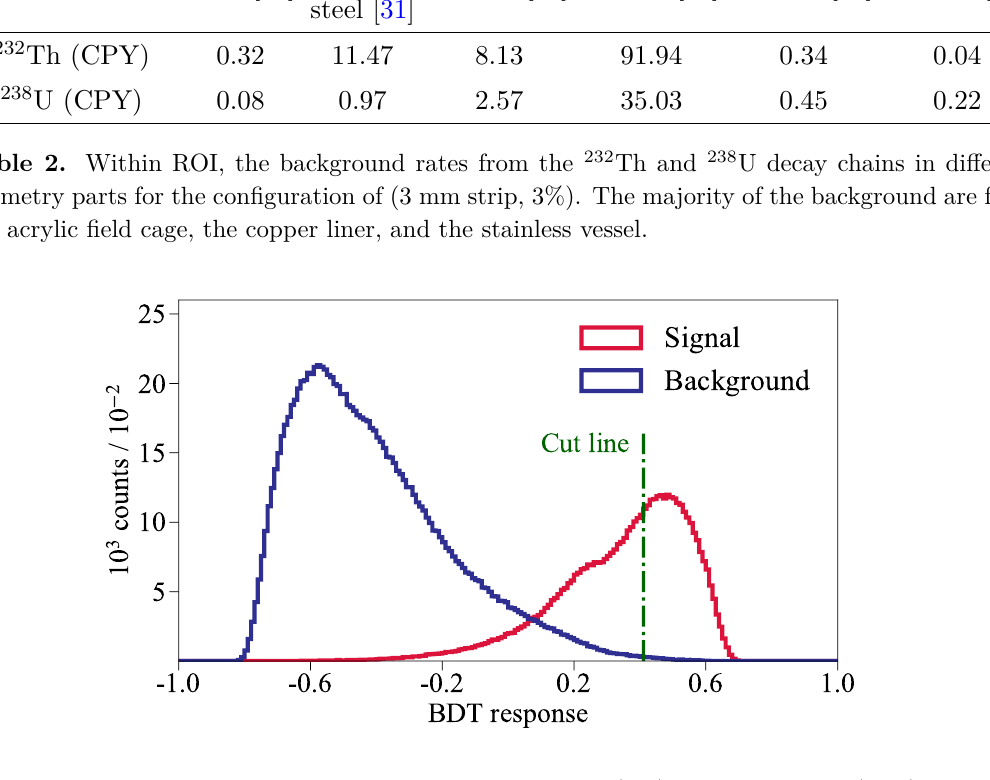
Figure 7. Classification output distribution of 0 νββ signal (red) and background (blue) with BDT cuts. The optimal cut line (green dash line) is determined for the best Ξ